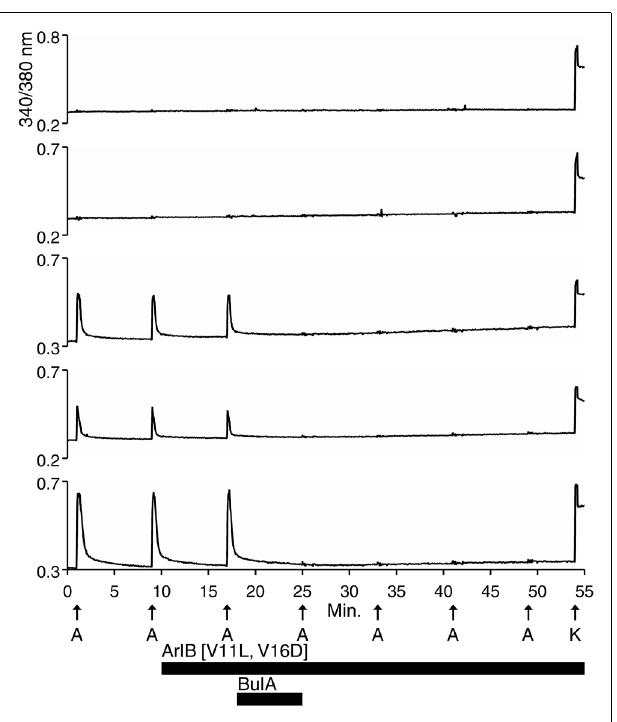
FIGURE 1 | Functional expression of nAChRs that contain β 4 subunits in a subset of rat DRG neurons. One mM ACh was applied to dissociated Rat DRG neurons at 8 min intervals as described in Section “Materials and Methods,” and as indicated by vertical arrows directly above the letter “A”